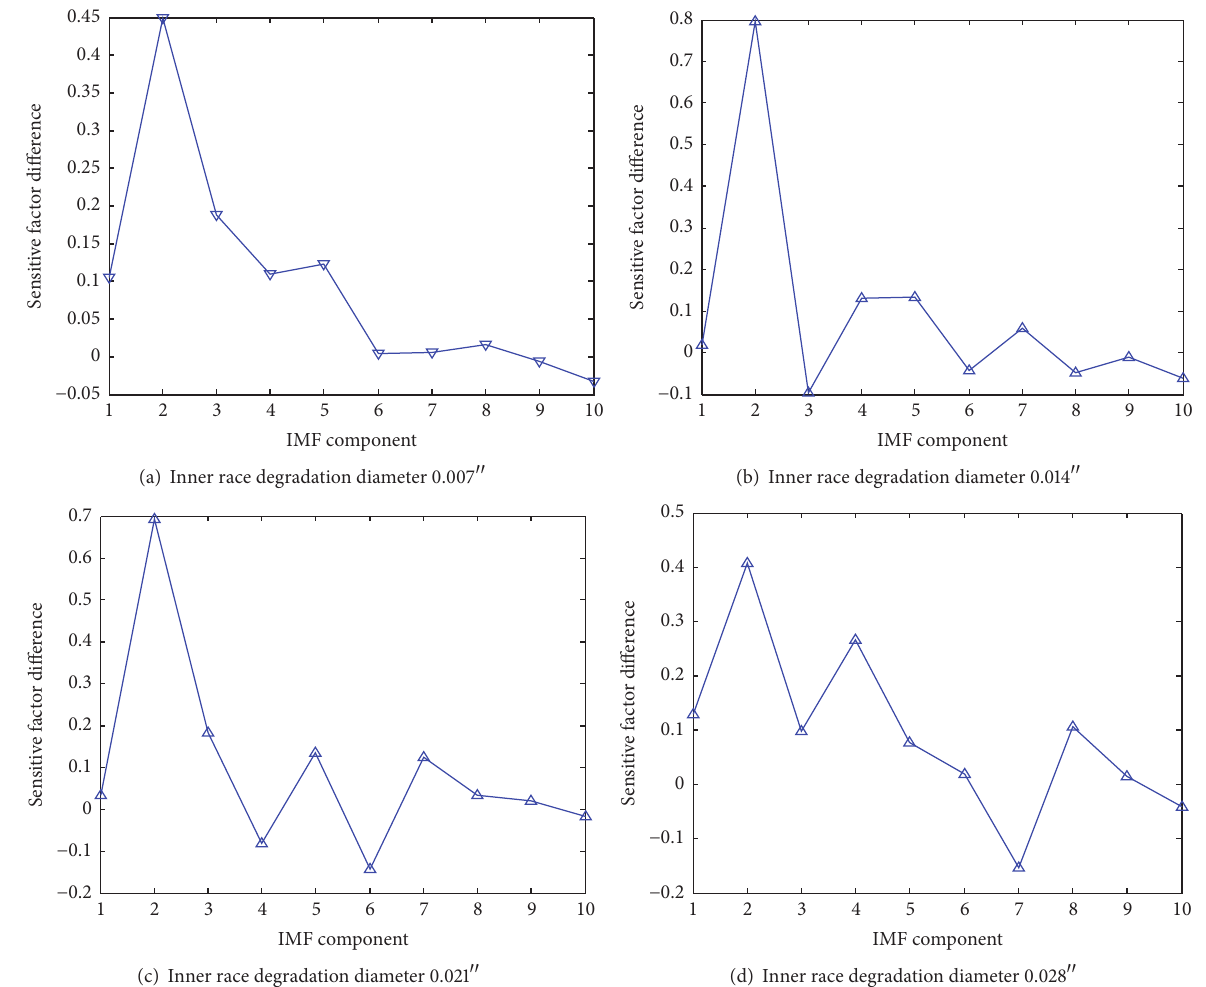
Figure 7: The sensitive IMF components based on similarity